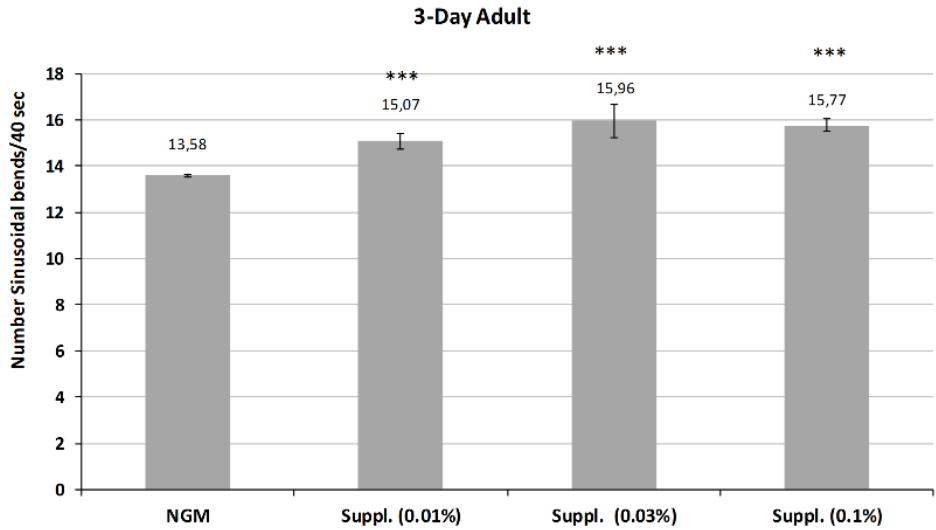
Figure 8. Mobility rate of C. elegans (N2) at 3-Day adult stage treated with the supplement at different doses. Number of body bends during 40 s measured in a total of 25 worms/condition/assay. *** Significant at p ≤ 0.001 vs. control NGM. Data are the average of two or three independent experiments.